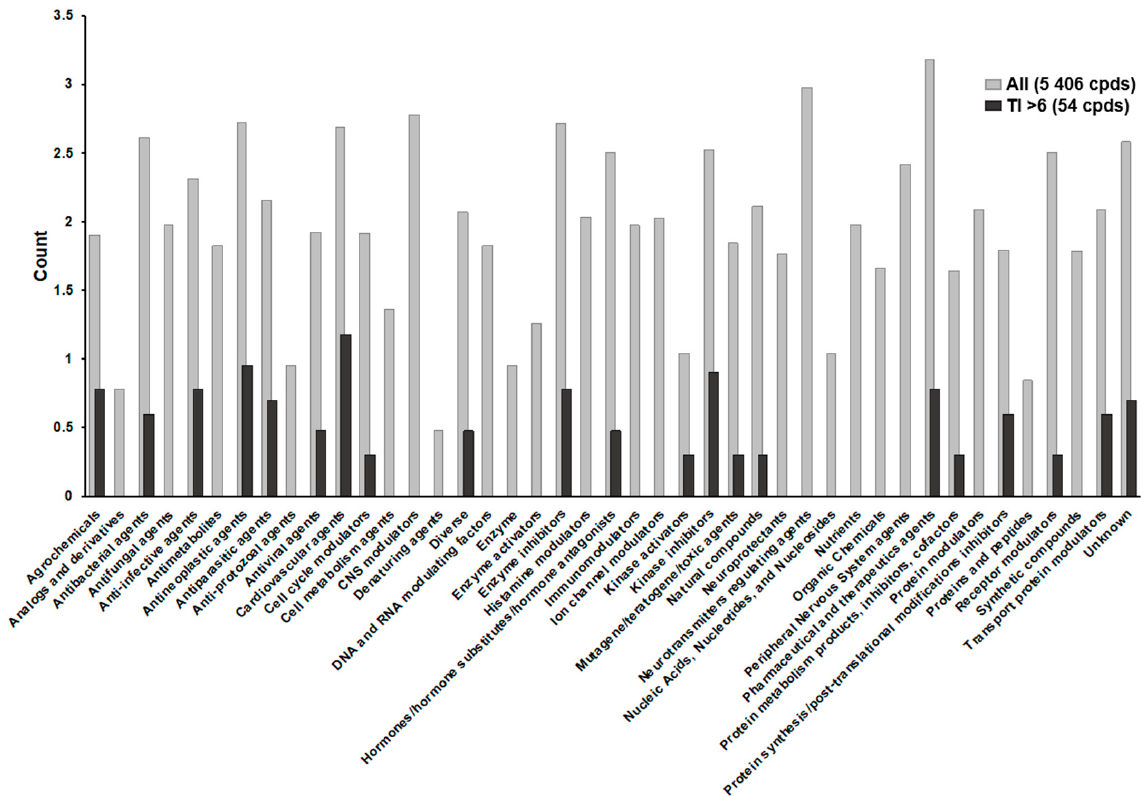
Figure 6. Pharmacological action profiling of all library compounds and confirmed hits. The 54 final hits were sorted into 43 pharmacological action categories. Gray and black bars indicate the distribution of all screened compounds and confirmed hits with a therapeutic index (TI) >6. The vertical axis displays counts of each compound on a log scale.